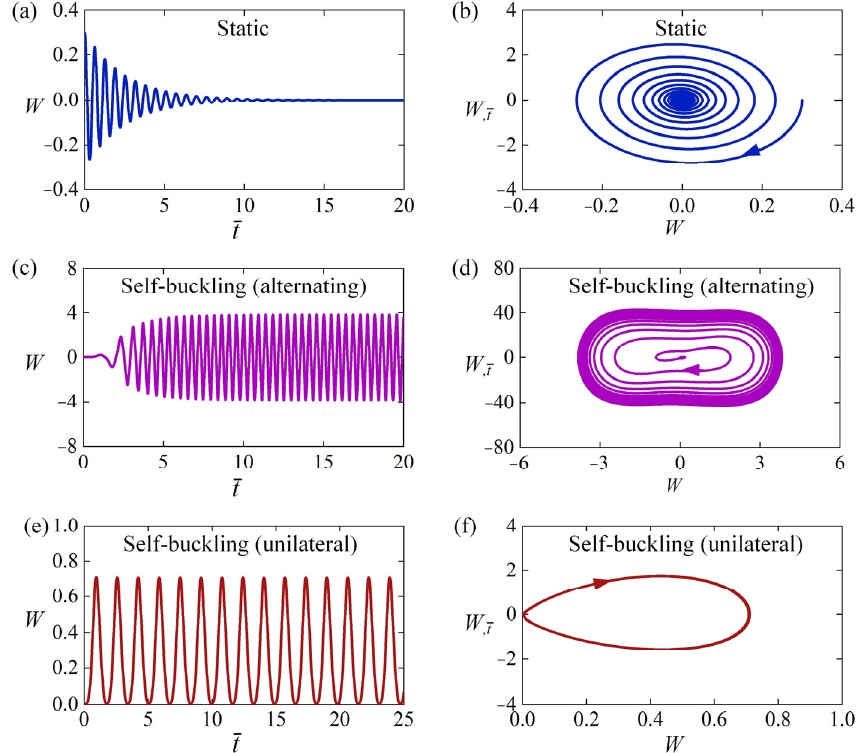
Figure 3. Time histories and phase trajectories of the two motion modes of the LCE rod: ( a , b ) The static mode for ε 0 = 0, β = 0.8, T 0 = 0.5, W 0 = 0.3 and W Euler buckling mode for ε 0 = 20, β = 0.5, T 0 = 0.5, W 0 = 0 and W self-sustained Euler buckling mode for ε 0 = 40, β = 13, T 0 = 0.5, W 0 = 0 and W